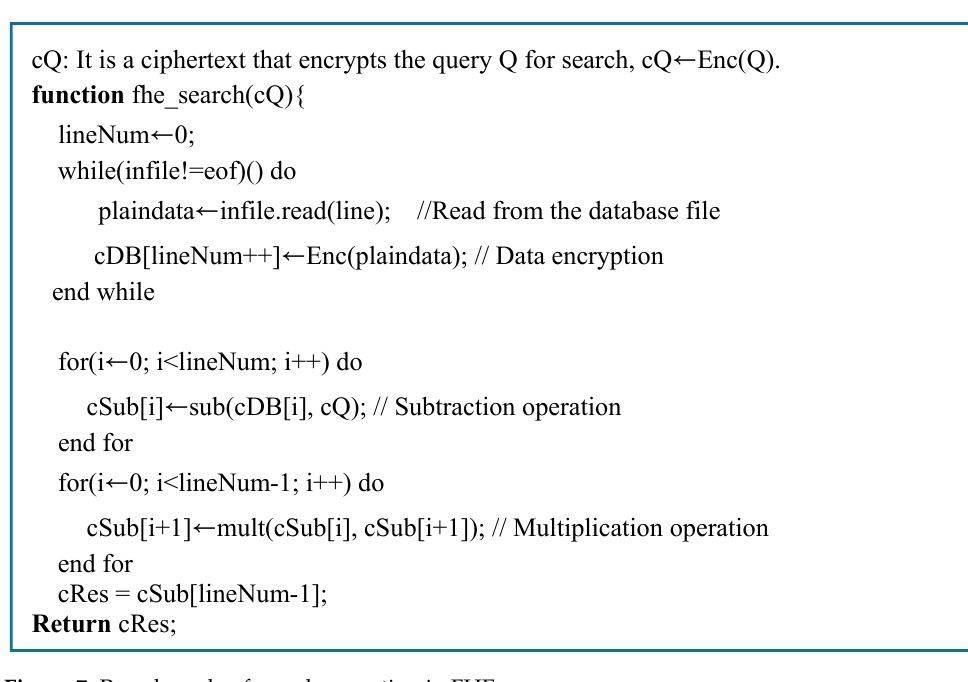
Figure 7. Pseudo code of search operation in FHE.